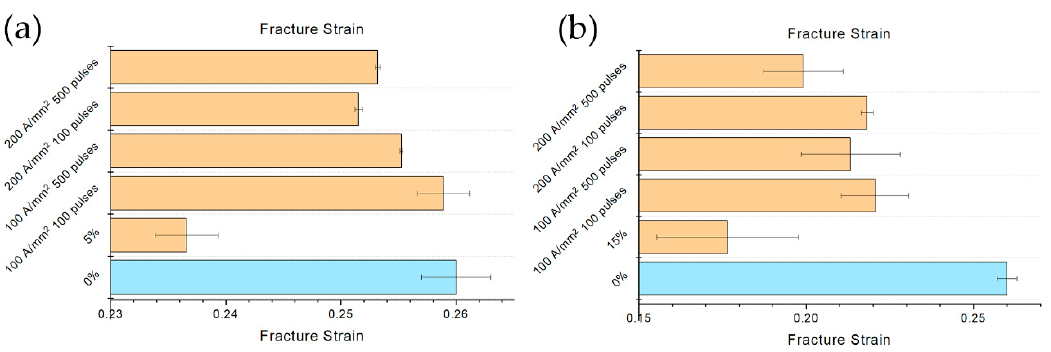
Figure 15. Evolution of fracture strain with respect the different electropulsing treatments and reference ( a ) 5% prestrained specimens and ( b ) 15% prestrained specimens.